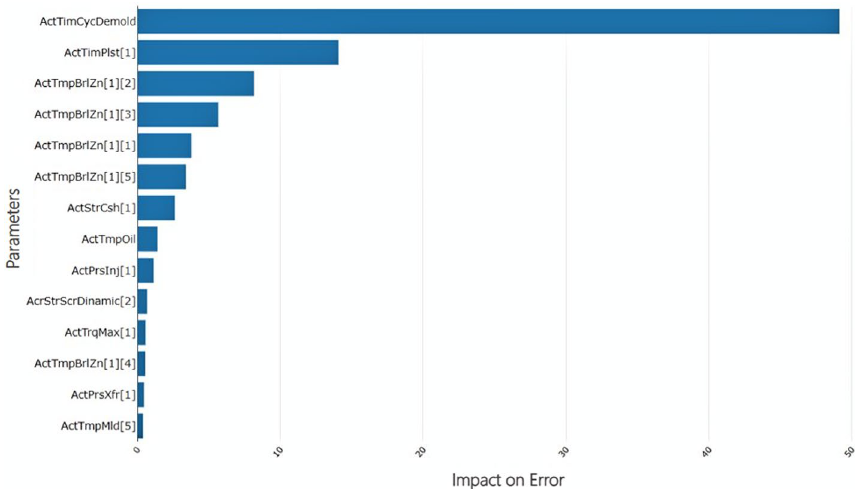
Fig. 13 The ranking of the impact of the parameters on the anomaly. 14 parameters that have more effect than other process parameters on the anomaly of a sample product are listed on the bar